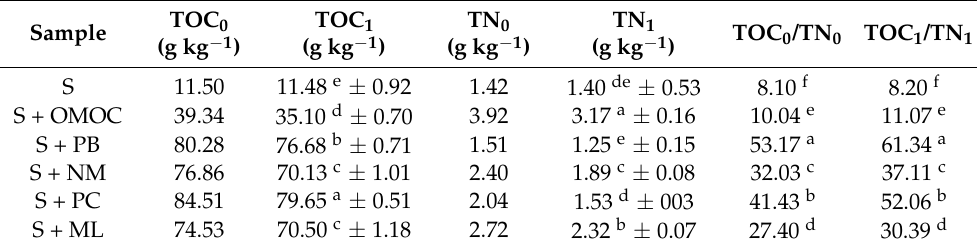
Table 2. Content of total organic carbon (TOC), total nitrogen (TN) and TOC/TN ratio in soil mixed with biochar before and after 60 days of incubation.